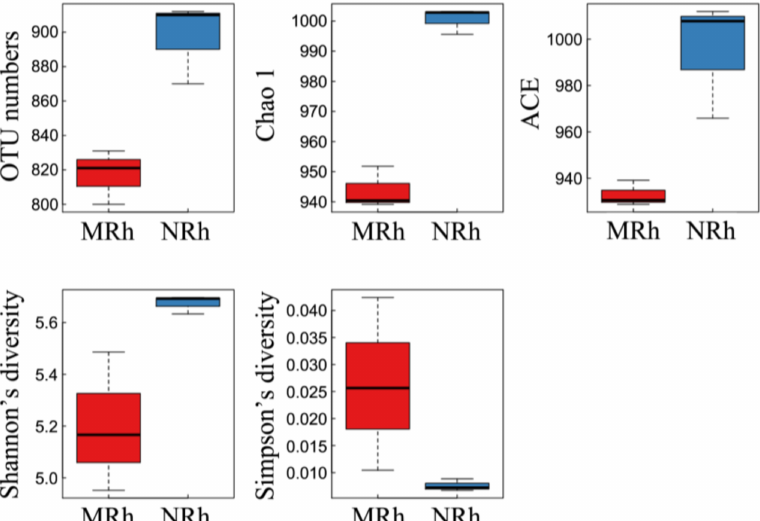
Figure 1. Boxplot analysis of five indices of alpha diversity. Five lines from top to bottom are the maximum value, the third quartile, median, the first quartile, and the minimum value. MRh represents the rhizospheric soil samples of the control soybean cultivar MD12 (n = 3). NRh represents the rhizospheric soil samples of the glyphosate-tolerant (GT) soybean line N698 (n = 3). OTU: operational taxonomical unit; ACE: abundance coverage-based